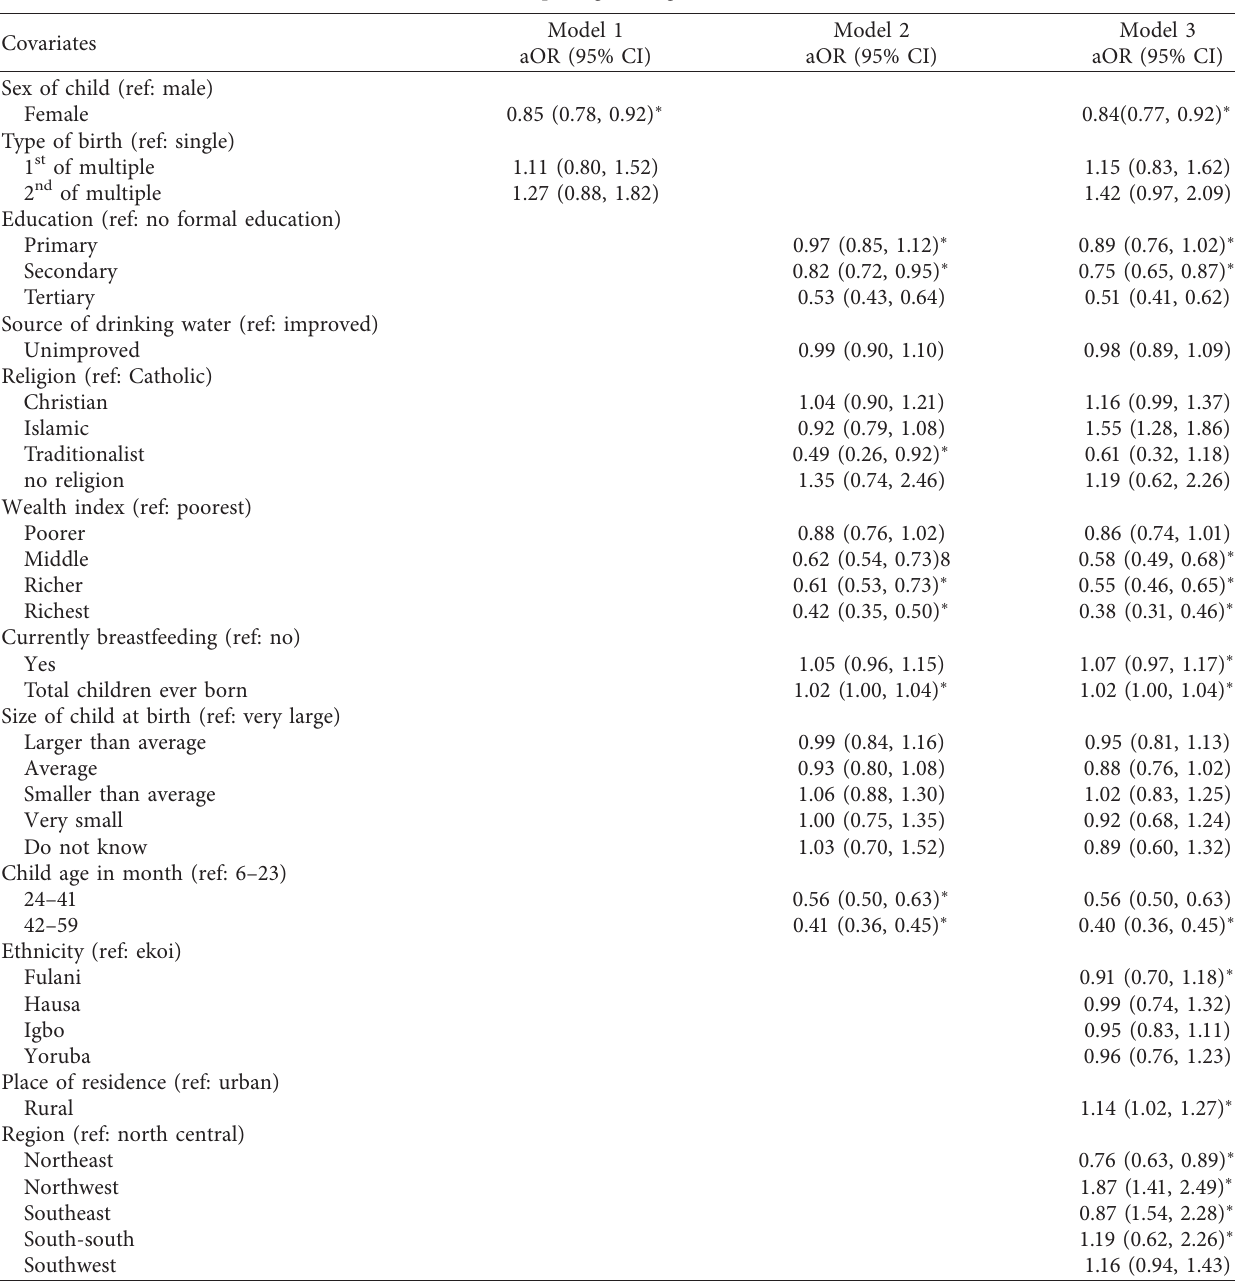
Table 3: Estimates of multiple logistic regression models (NDHS